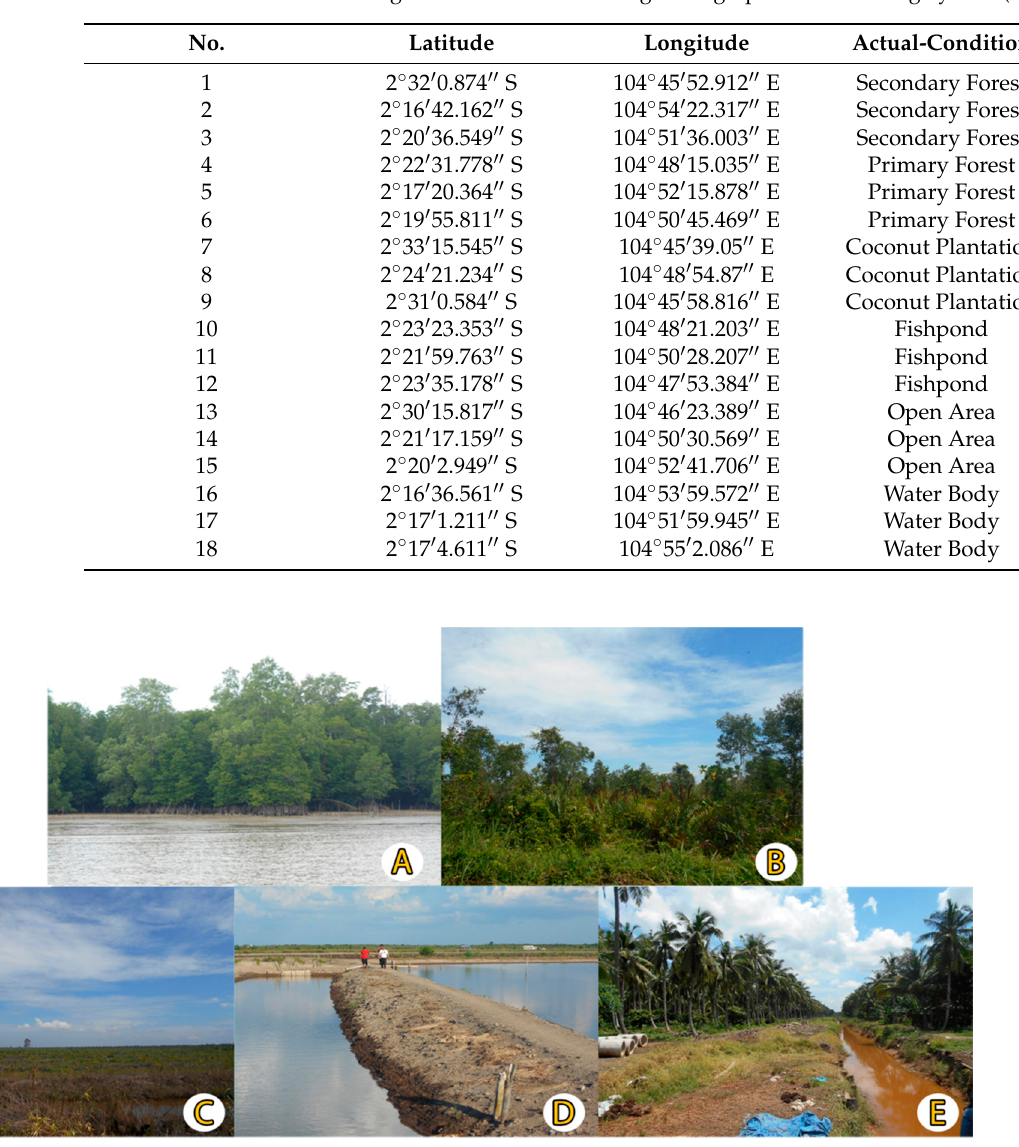
Table 2. The coordinates of the ground check results using a Geographical Positioning System (GPS).